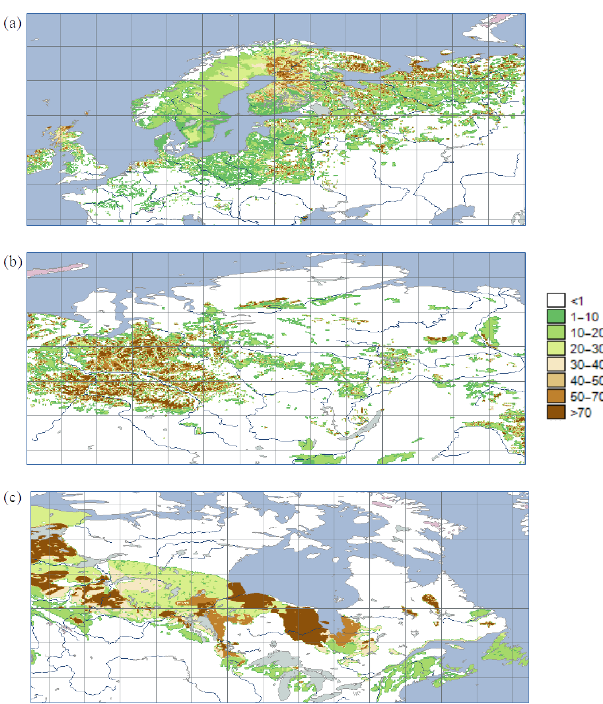
Figure 2. The fraction of histosols (%) in Europe (a) , western Siberia (b) , and Canada (c) .